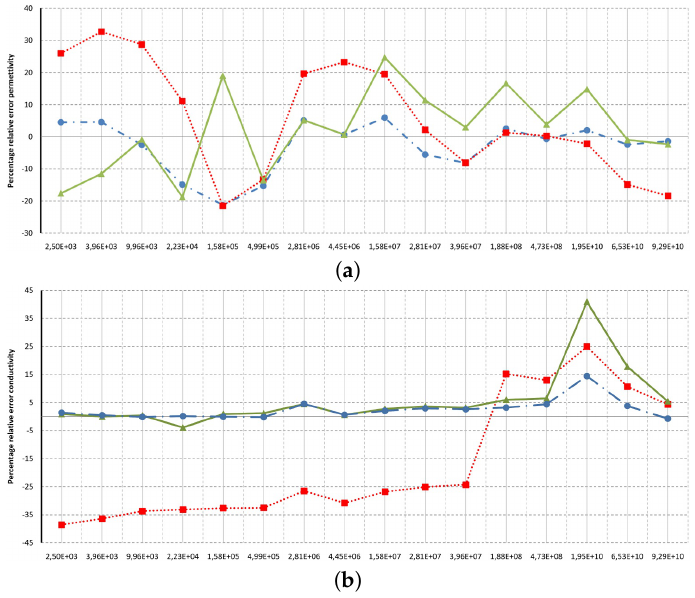
Figure 9. Relative percentage error ( a ) permittivity and ( b ) conductivity. Line dot-dashed fractional model, line continue Ciancio–Kluitenberg model, line dotted extensive Cole–Cole’s model, points experimental